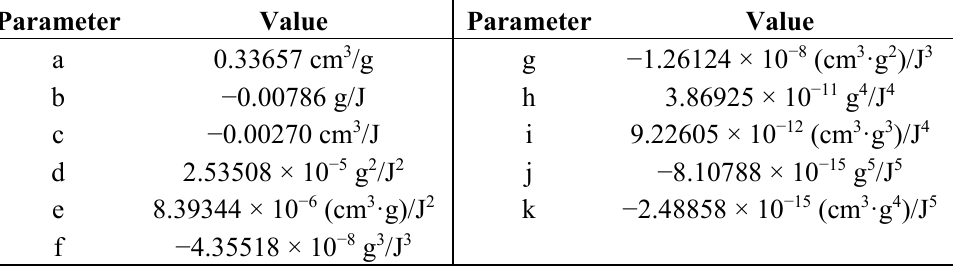
Figure 6. Schematic of the set-up for the characterization of small AdHEX. Table 3. Parameters for the standardized Dubinin characteristic